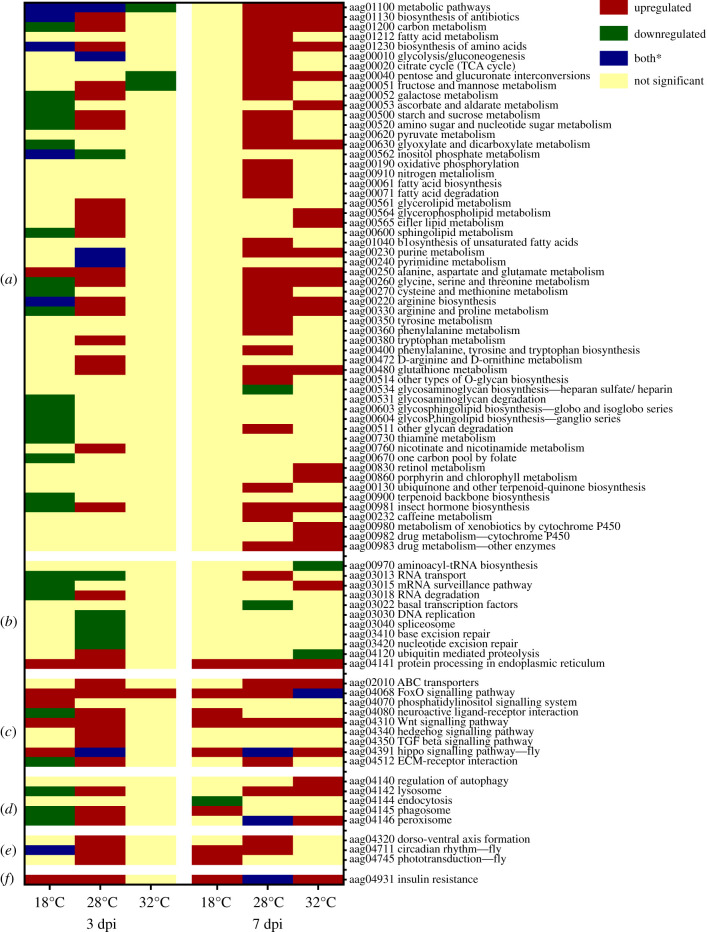
KEGG pathway analysis for DEGs found at 3 dpi and 7 dpi. (a) Metabolic pathways; (b) genetic information processing; (c) environmental information processing; (d) cellular processes; (e) organismal systems; (f) human diseases. ‘aag’ followed by numbers indicate the KEGG pathway identification number. *Denotes both upregulated and downregulated components to the pathway.